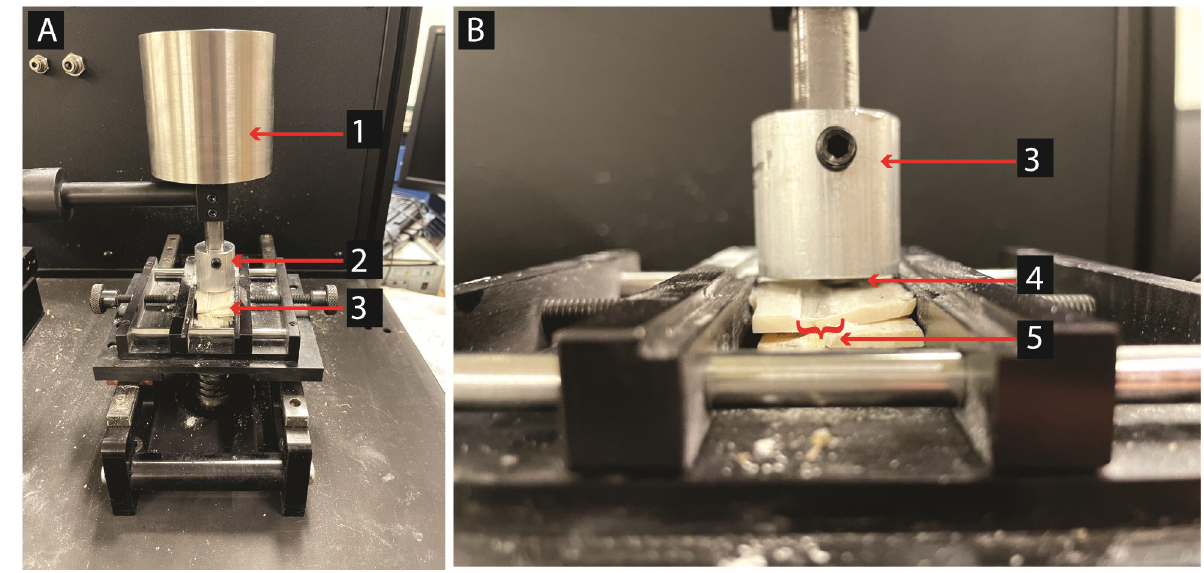
Fig 1. Tribometer setup. A: overview; 1: Load(20N); 2: sample holder; 3: worked material (ivory). B: close-up; 3: worked material (ivory); 4: chert bit; 5: wear track.